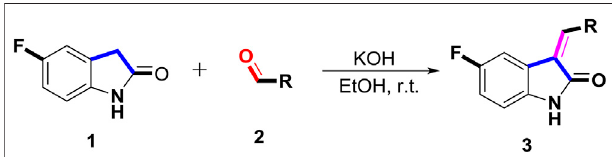
TABLE 1 | α -Glucosidase inhibitory activities of compounds (3a ~ 3v ).